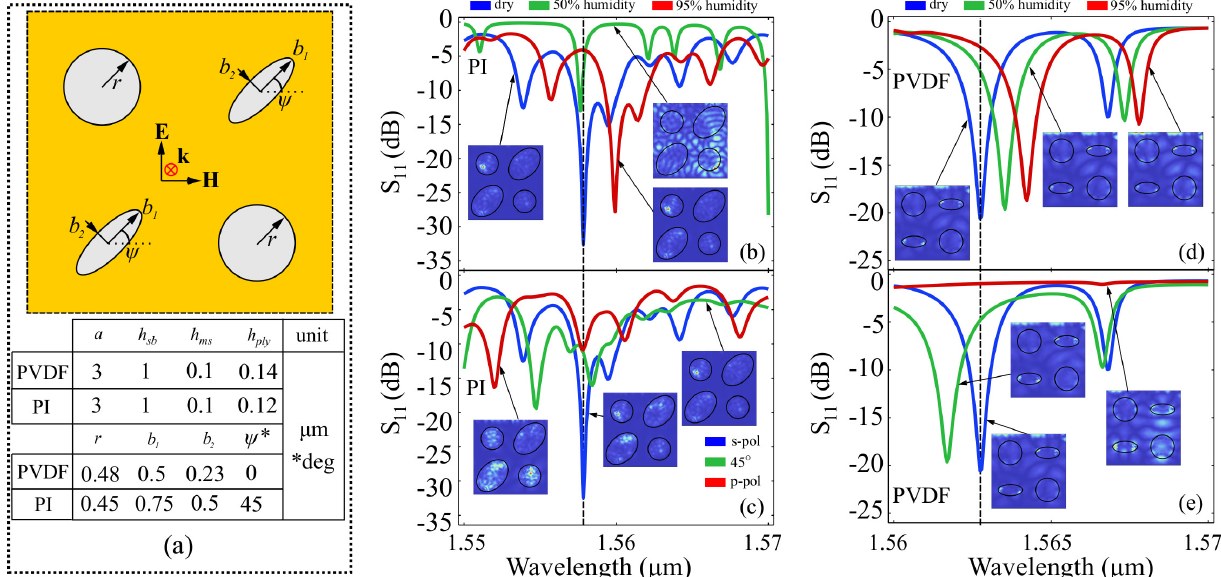
Figure 4. Results obtained for the disk-element architecture. ( a ) Layout of the ring elements and element sizes chosen for the PVDF and PI in order to have a resonant response around the working wavelength; ( b ) spectral behavior of the PI disk-element structure at different humidity levels and ( c ) at different input polarization states; and ( d ) spectral behavior of the PVDF disk-element structure at different humidity levels and ( e ) at different input polarization states. For subfigures ( b – e ), the insets show the local field enhancement in the interface plane taken at the resonance